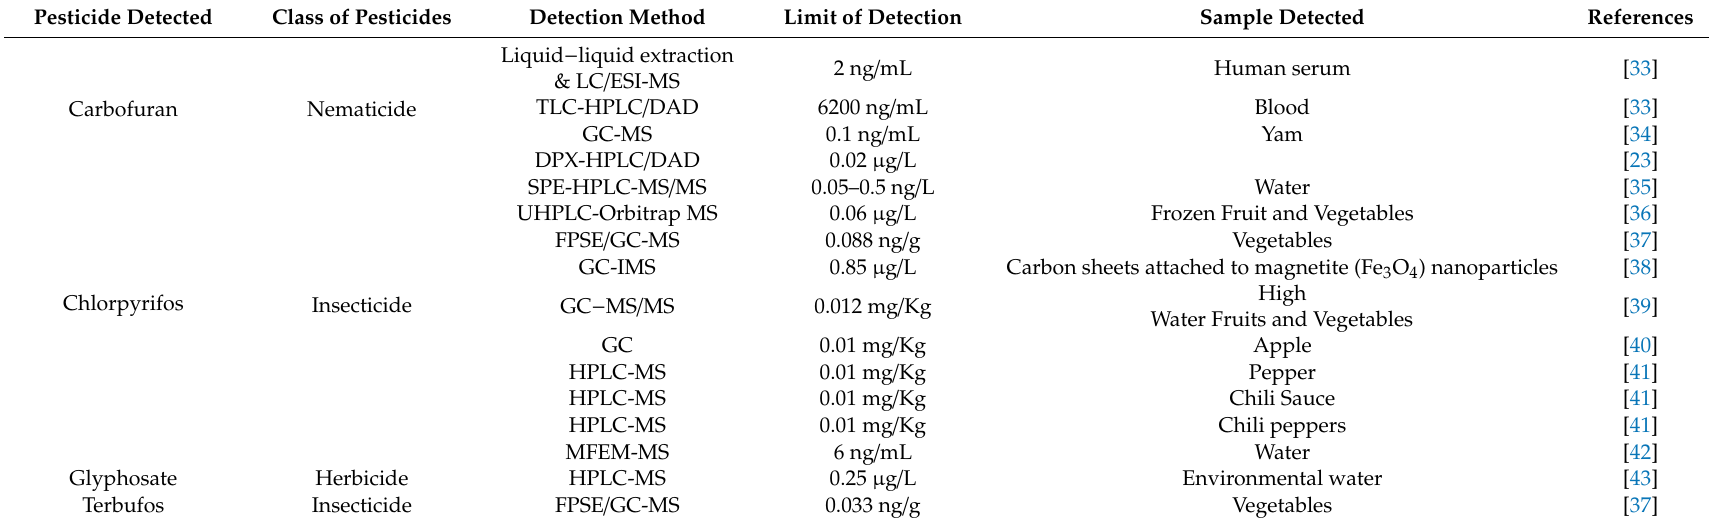
Table 2. Comparison of the GC and HPLC methods for the determination of